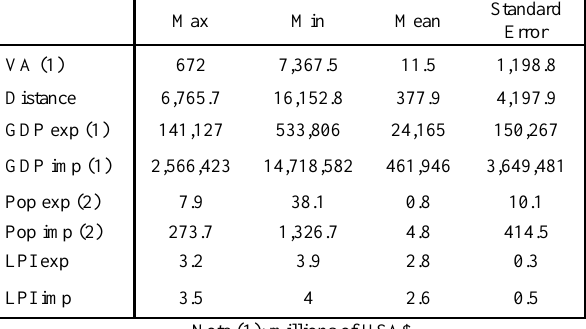
Table 2A: Main Statistics 2008 for Group 1